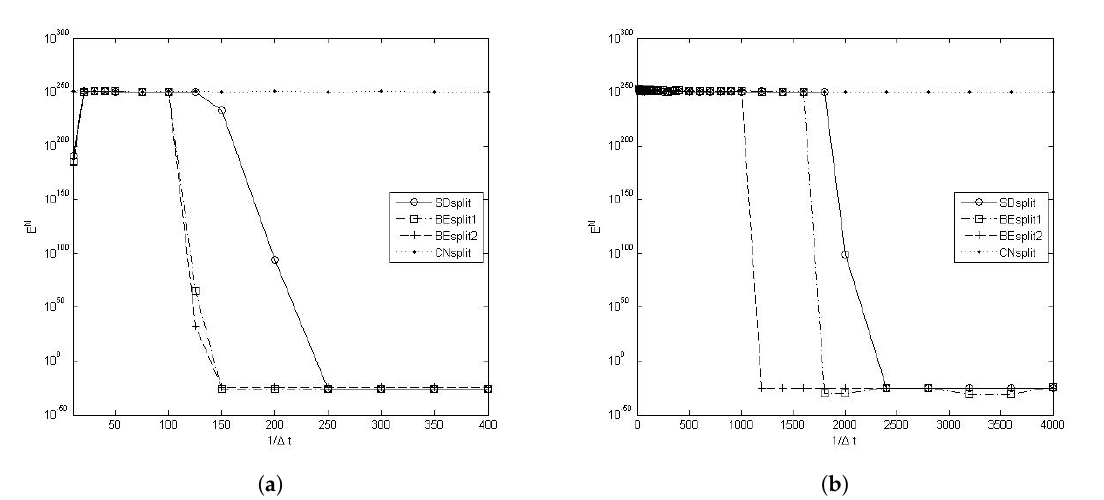
Figure 3. A comparison of E N computed using different choices of time step for different splitting methods with ’moderately small’ k min and ’moderately small’ S 0 . ( a ): k min = 10 − 3 and S 0 = 10 − 3 . ( b ): k min = 10 − 4 and S 0 = 10 − 4 ,